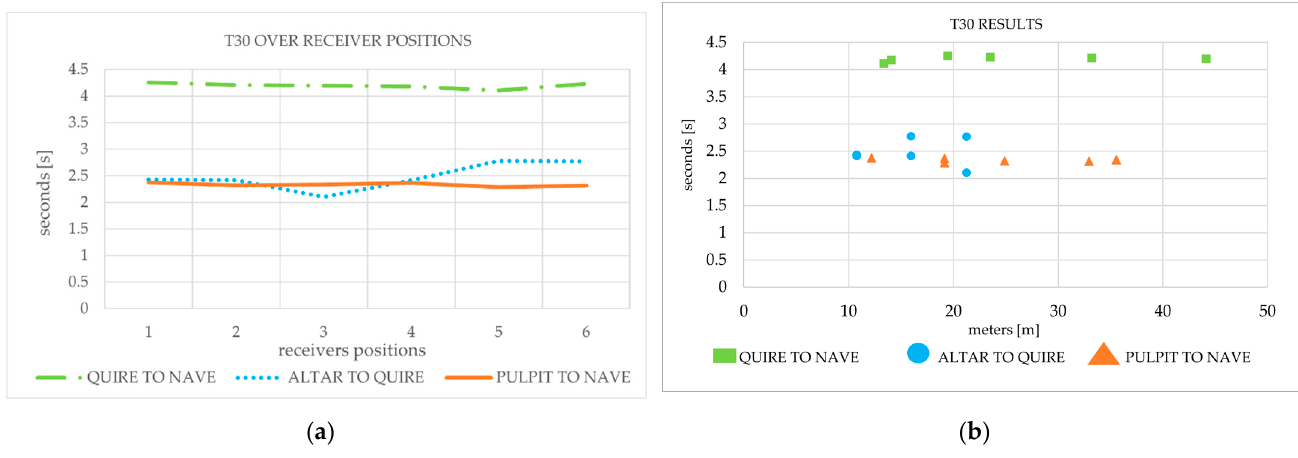
Figure 9. mid-frequency [500 Hz–1 kHz] T30 results: ( a ) T30 results over receiver positions; ( b ) T30 results over distance.